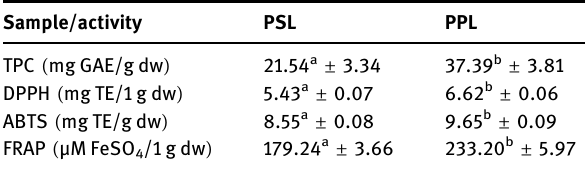
Table 5: The electrochemical parameters determined for extracts from P. padus and P. serotina